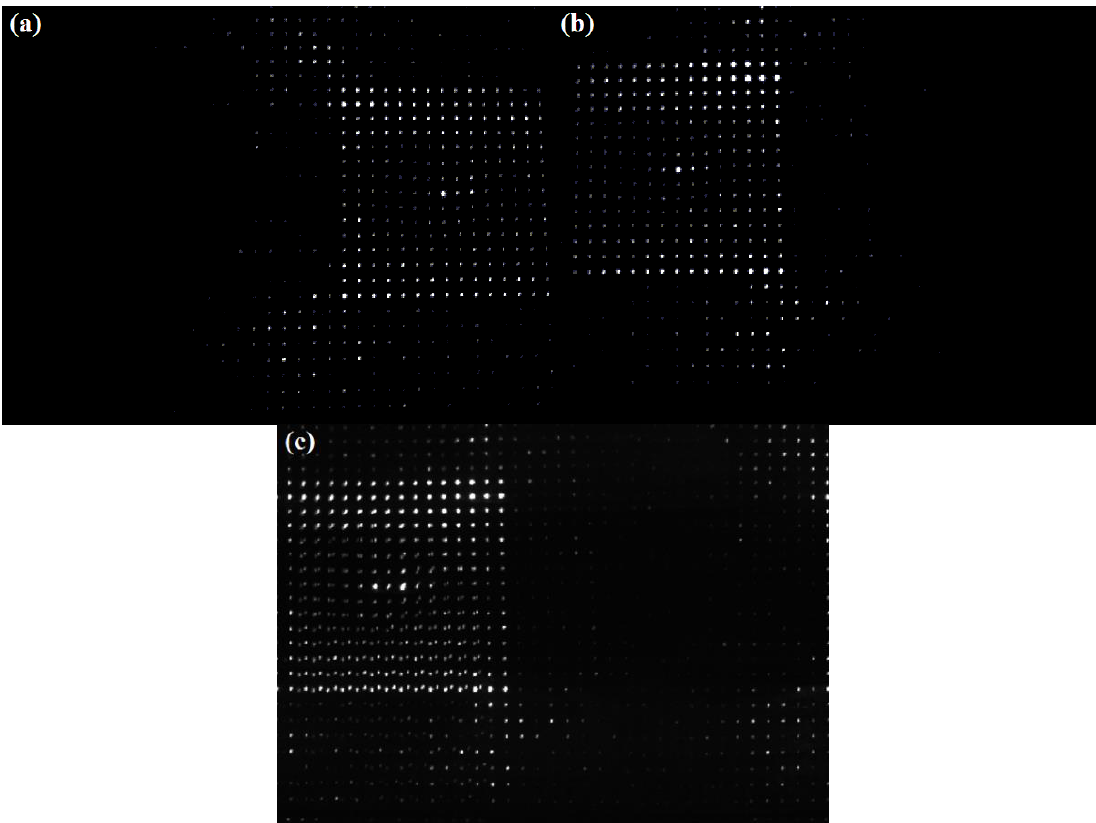
Figure 13. Surface images containing laser dots in dim light condition. ( a ) Processed image captured from Camera 1. ( b ) Processed image captured from Camera 2. ( c ) The matching results of figure ( a ) with respect to figure ( b ).